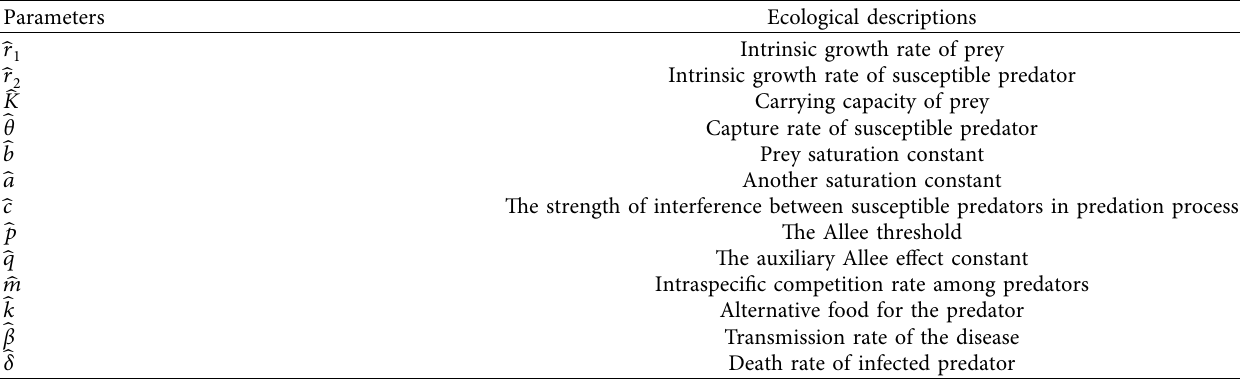
Table 1: Parameter description in system